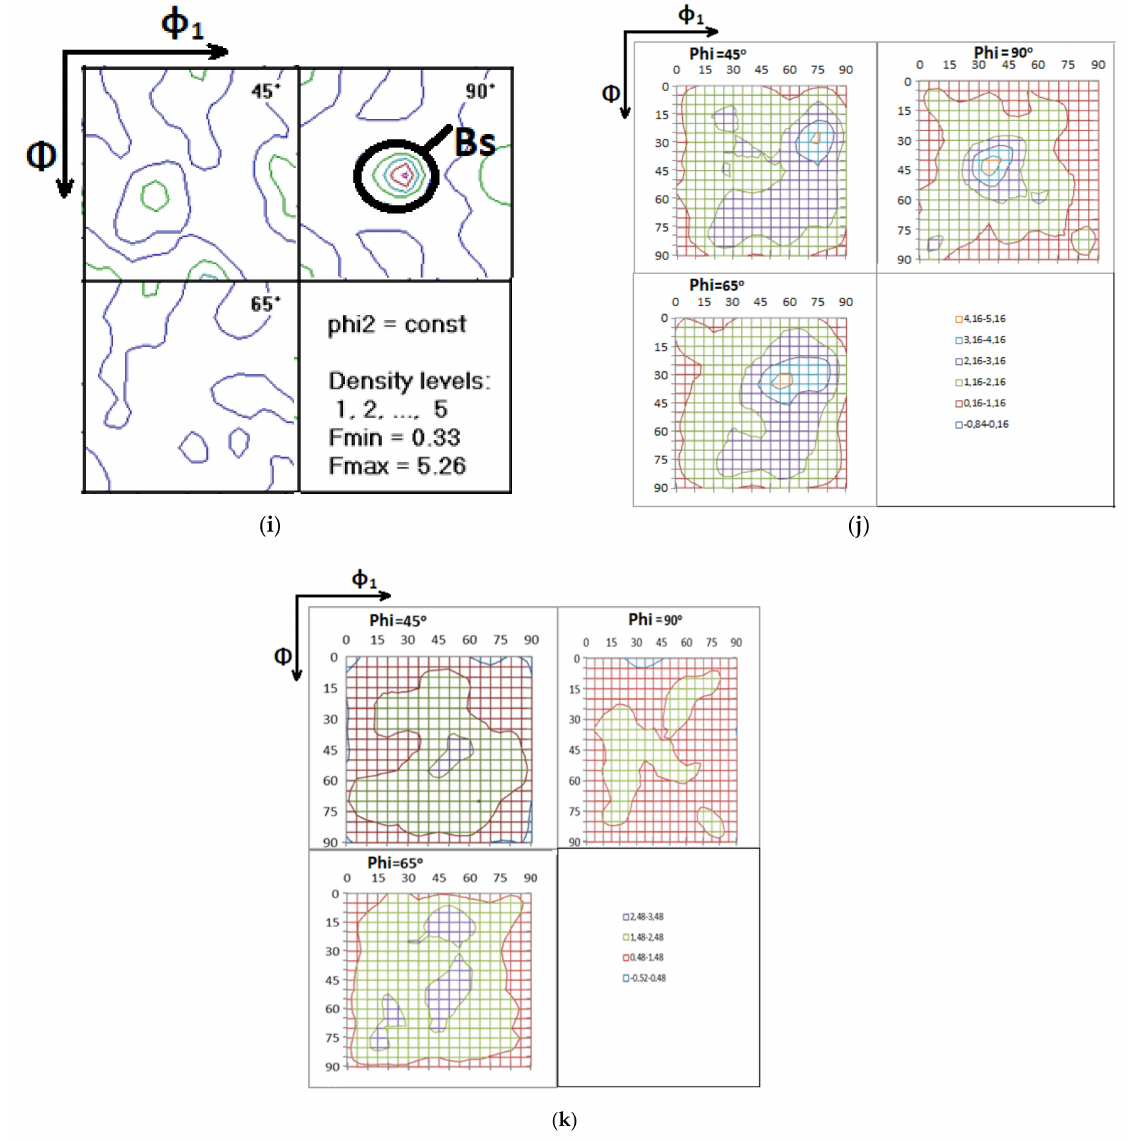
Figure 20. Calculation results for 5182 alloy: ( a ) homogenization, ( b ) 33.2% deformation, ( c ) 33.2% deformation (modeling); ( d ) 83.53% deformation; ( e ) 83.53% deformation (modeling); holding at 32.2% deformation and elevated temperature: ( f ) experimental data. Calculation results for 5182 alloy: ( g ) taking fragmentation into account, ( h ) without regard to fragmentation of intermetallic compounds; holding at 83.53% deformation and elevated temperature: ( i ) experimental data, ( j ) taking fragmentation into account, ( k ) without regard to fragmentation of intermetallic